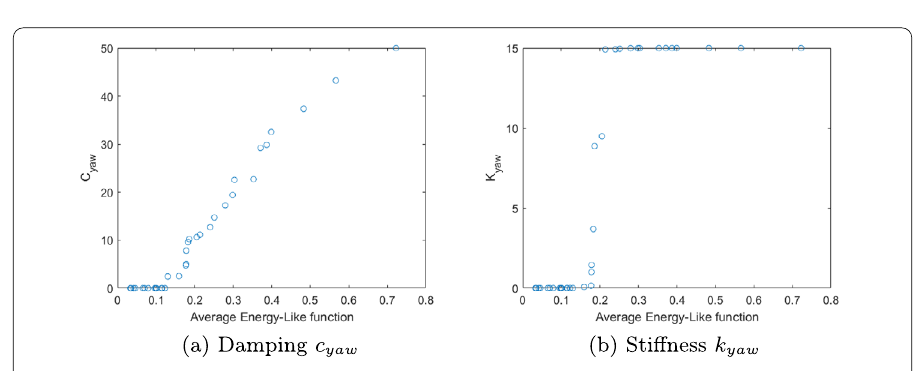
Figure 13 Damping and stiffness for the roll axis against the average kinetic energy-like function